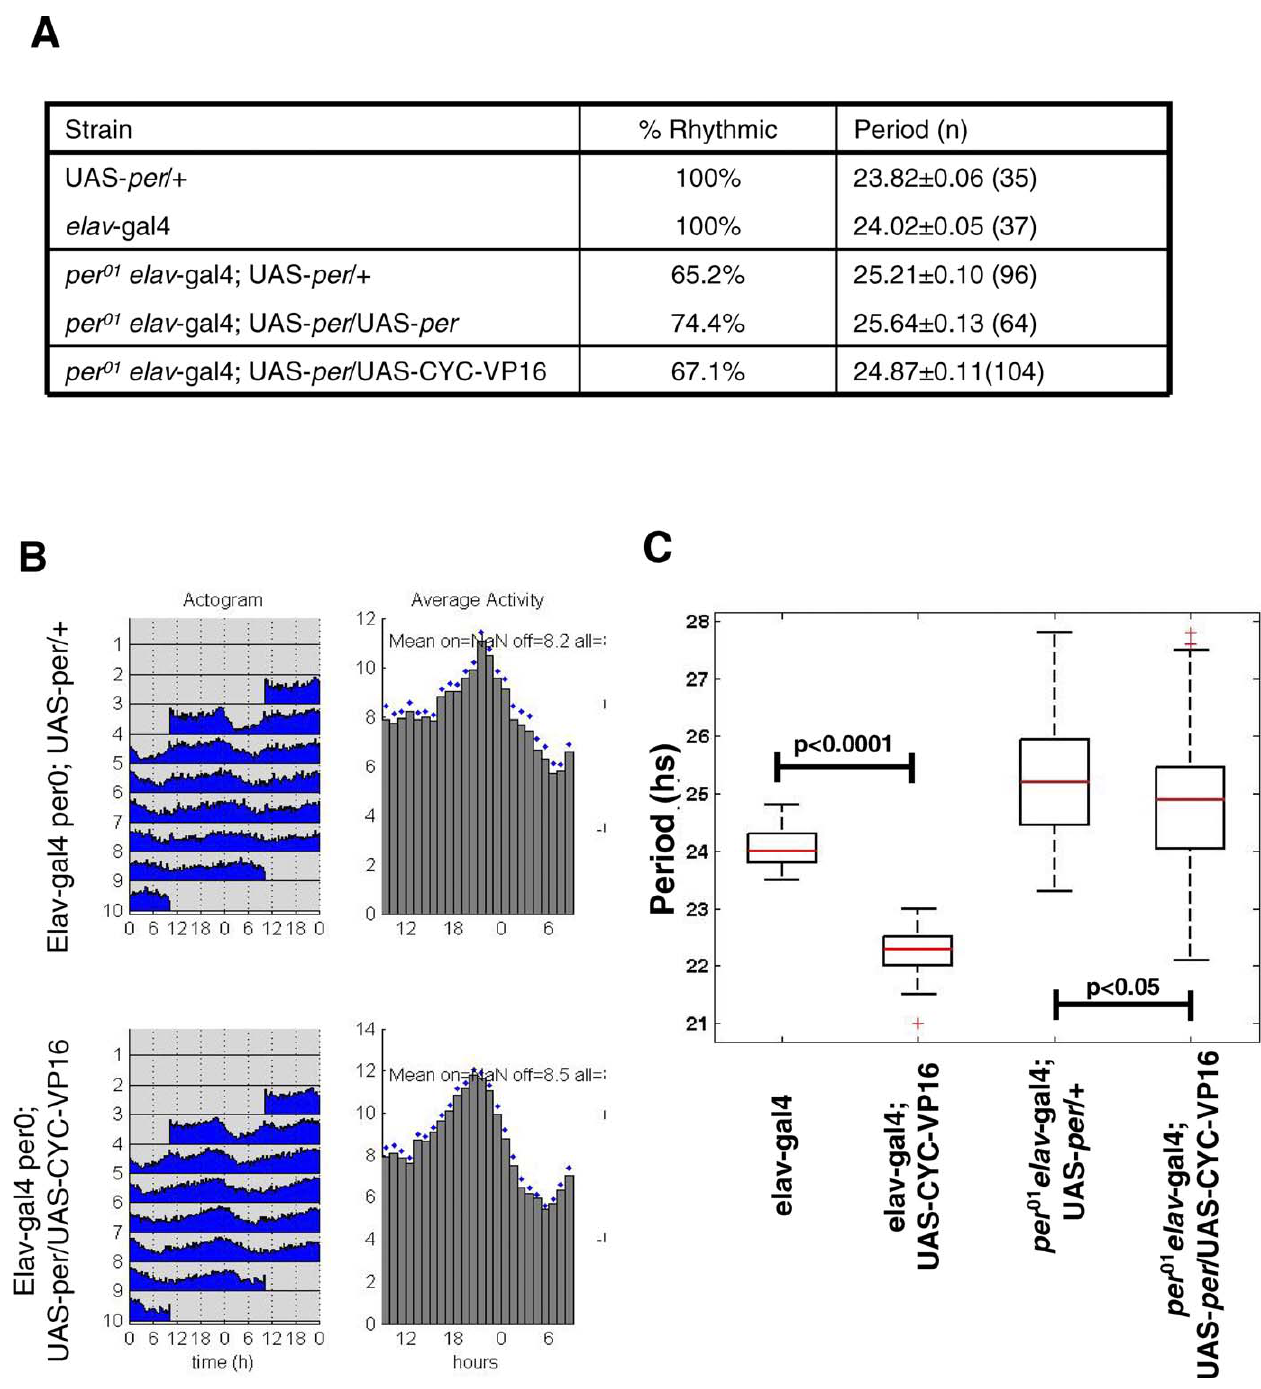
Figure 7. Period Effect of cyc - vp16 Is Mainly Mediated by per Transcription (A) Period length analysis of fly strains overexpressing uas - cyc - vp16 using the elav-gal4 driver and control flies in different genetic backgrounds. (B) Locomotor behavior of per 01 ; elav-gal4 ; uas - per flies with or without a uas - cyc - vp16 transgene in DD conditions. The behavior is shown in actograms (left) and averaged actograms (right). (C) Box plot showing the period distribution of the specified flies. The p -values correspond to a t -test performed among the indicated samples.